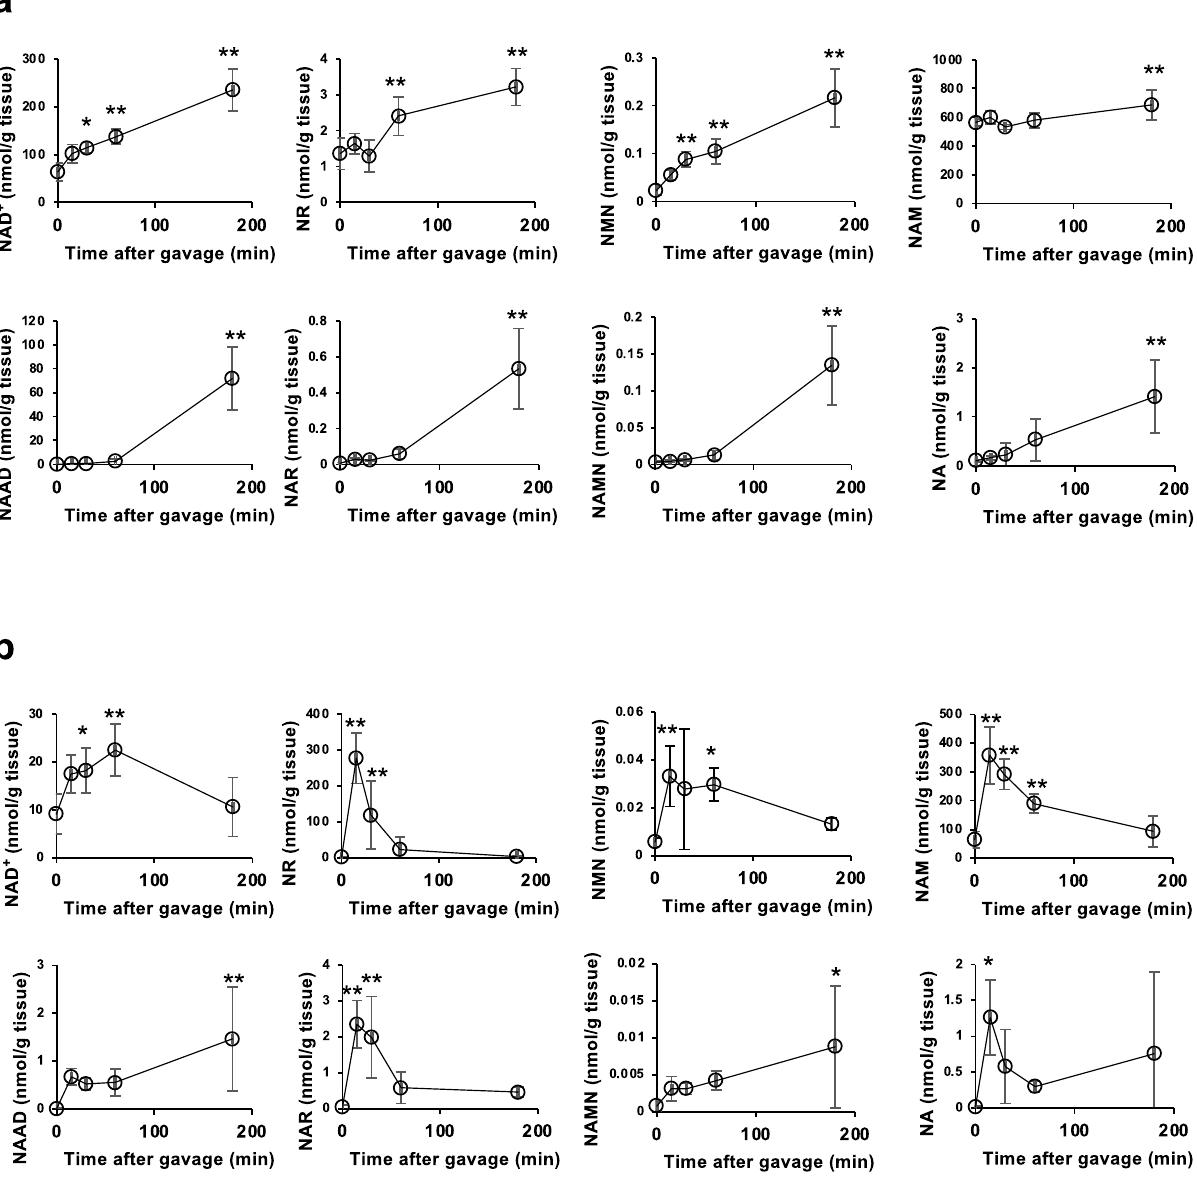
Fig. 1 Time-course analysis of NAD + metabolome after the gavage of NR. 400 mg/kg NR was administered to wild-type mice ( n = 6 mice per time point) by gavage and killed after 0 m, 15 m, 30 m, 1 h, and 3 h for tissue collection. Relative abundance of NAD + metabolome in the liver ( a ) and small intestine ( b ) were shown. Data are shown as mean ± S.D. * P < 0.05, ** P < 0.01 as determined by one-way ANOVA followed by Tukey ’ s post-hoc tests. Source data are provided as a Source Data fi